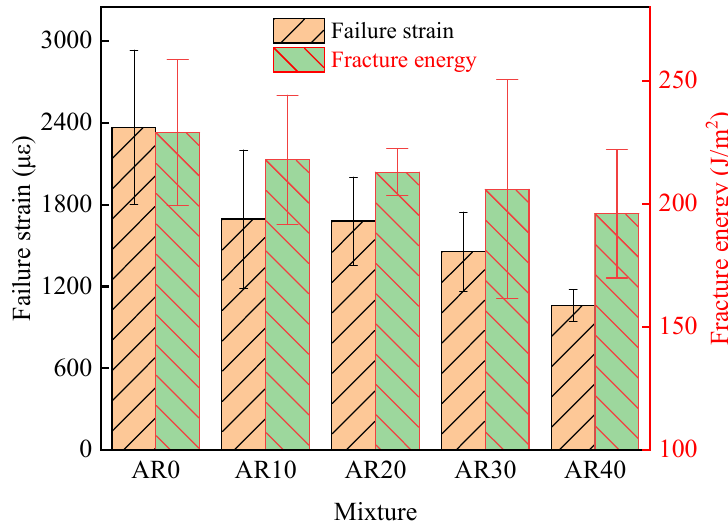
Figure 7. Failure strain and FE of various mixtures.